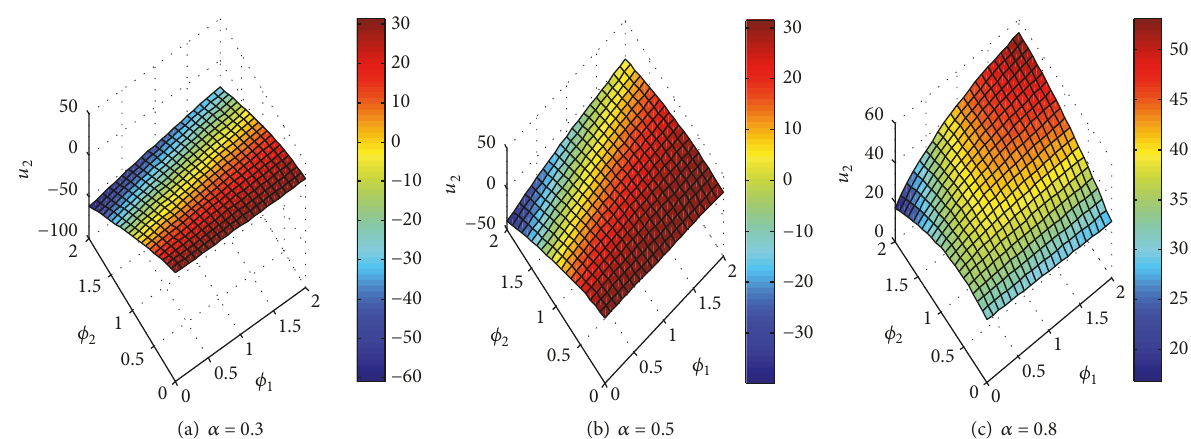
Figure 10: The impact of fairness concern on player 2’s expected utility u 2